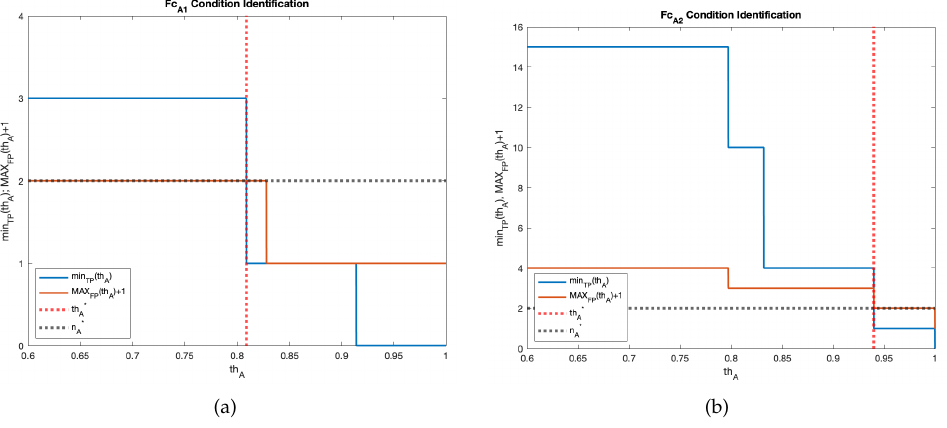
Figure 5. Fc A condition identification: ( a ) audio NN #1 and ( b ) audio NN #2.